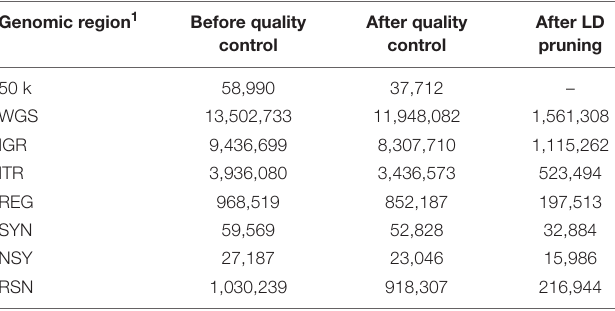
TABLE 2 | Number of variants annotated in different genomic regions before and after quality control and after LD pruning. Genomic region